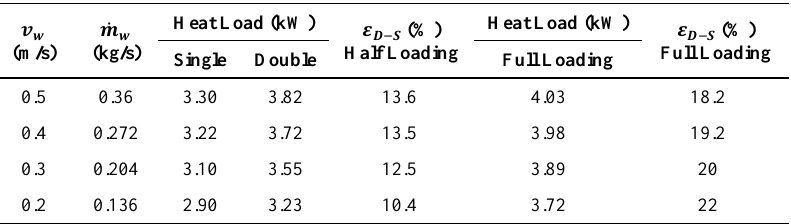
Table 3. Heat transfer rate enhancement factor of the double U-tube heat exchanger